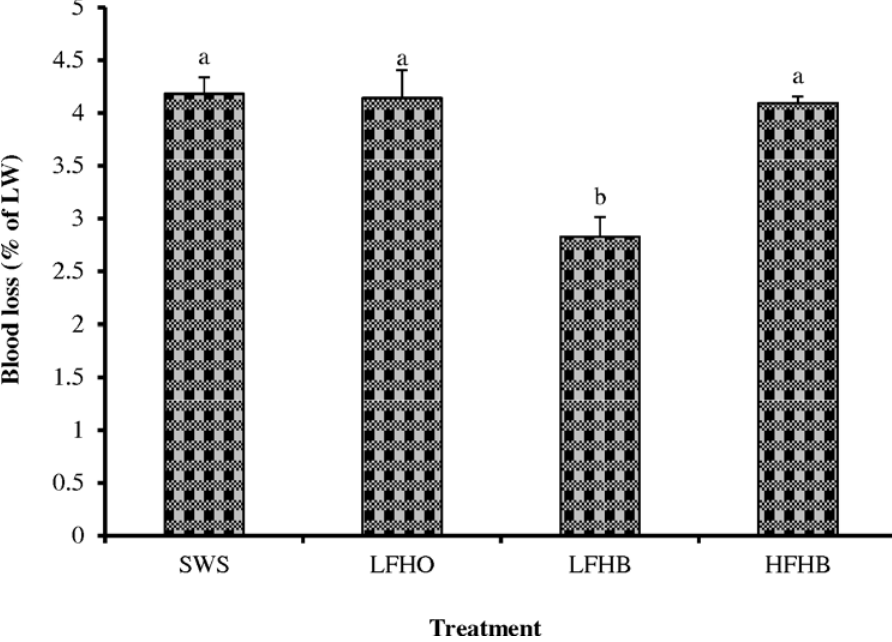
Fig 2. Blood loss in goats subjected to slaughter without stunning and slaughter following different methods of electrical stunning. SWS: slaughter without stunning, LFHO: low frequency head-only, electrical stunning, LFHB: low frequency head-to-back electrical stunning, HFHB: high frequency head-to- back electrical stunning. Values with different superscripts differ significantly at p < 0.05. LW: live body weight pre-slaughter. Values are means ± 1 standard error (n =